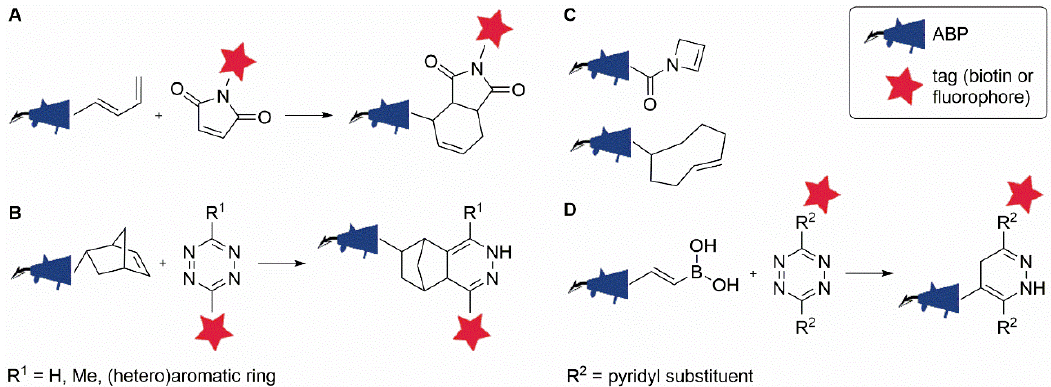
Figure 4. Diels–Alder-type bioorthogonal ligation reactions that have been used in combination with ABPP. ( A ) Diels–Alder ligation. ( B ) Inverse electron-demand Diels–Alder ligation (iEDDA) between